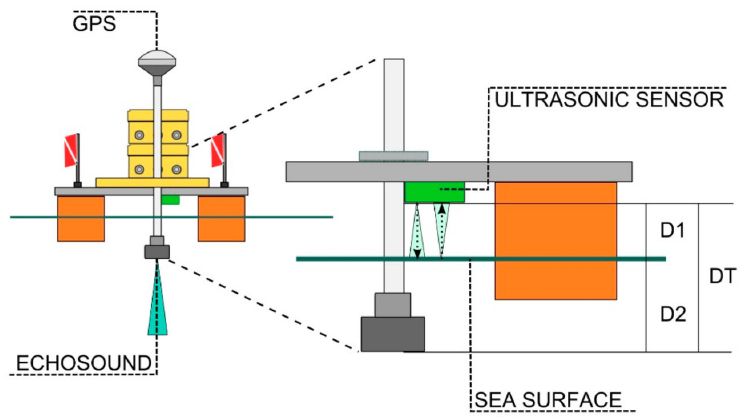
Figure 11. Acoustic system for the draught